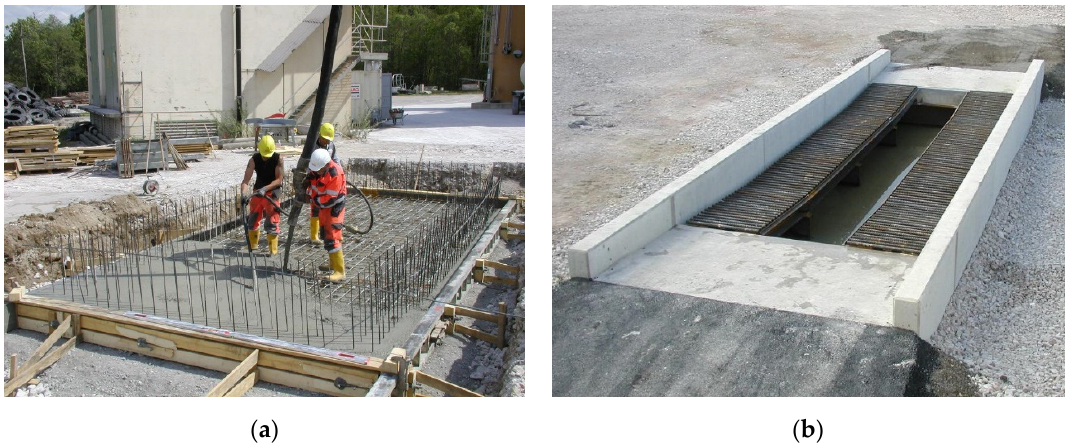
Figure 11. Test track construction using (1) CEM V/A (S-V) 32.5 R using a cement content of 400 kg/m³ and a water-binder ratio of 0.45 during ( a ) concreting work and ( b ) after finishing the construction.